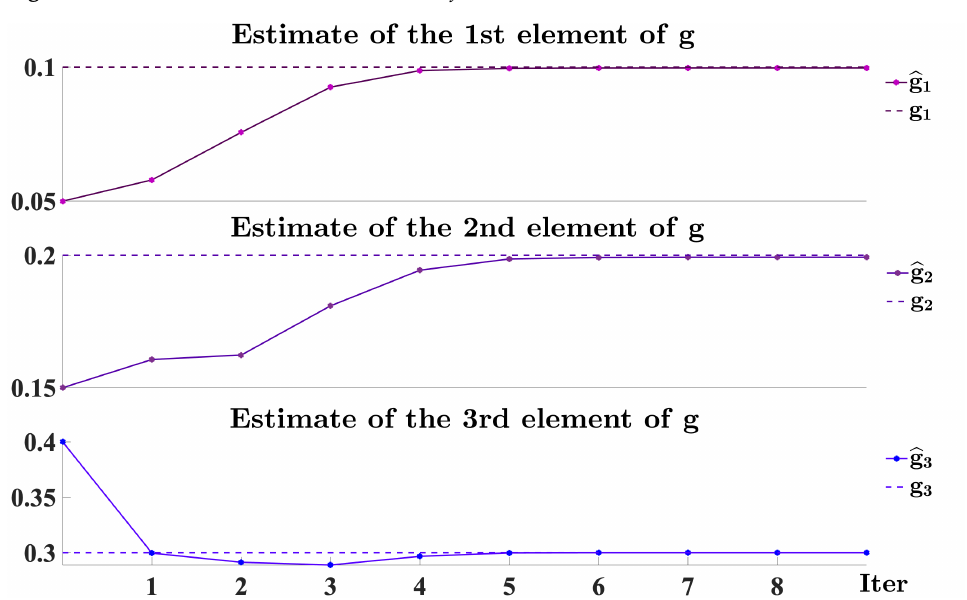
Figure 5. Estimation of the observation drift f elements.